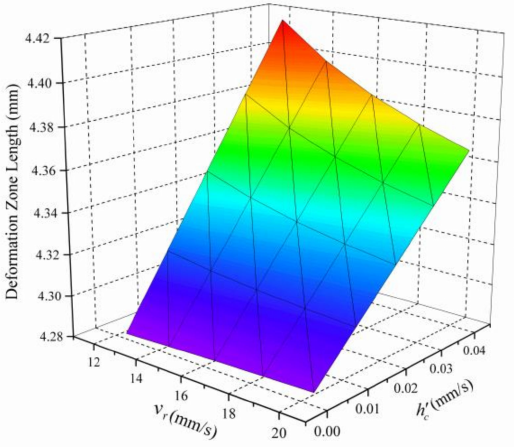
Figure 12. The influence of rolling velocity and roll gap reduction velocity on the deformation zone length (2 h 1 = 1.57